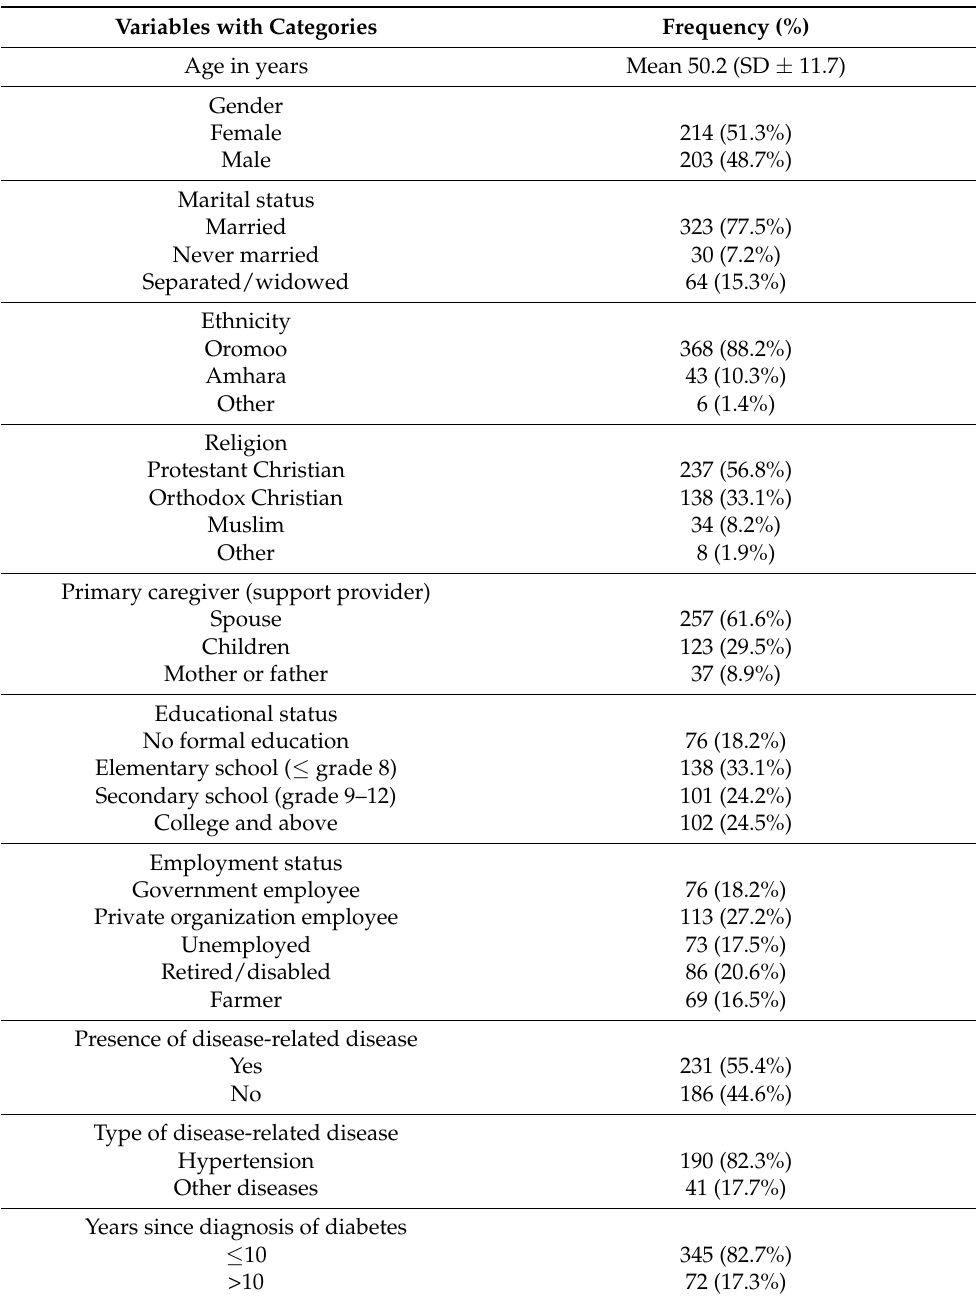
Table 1. Sociodemographic characteristics of people living with type 2 diabetes attending Nekemte Specialized Hospital, 2020 ( n =